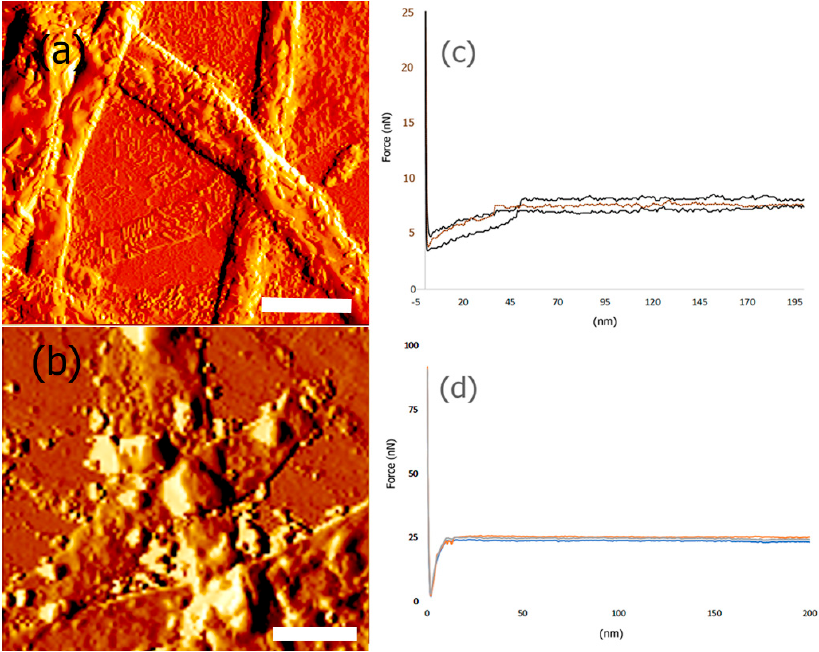
Figure 8. AFM amplitude image of ( a ) biocomposite nanoribbons bound to laminin, artemin and collagen. Scale Bar = 10 μ m; ( b ) nanoribbons bound to laminin, artemin and collagen and PANI. Scale Bar = 5 μ m. ( c ) Force curves obtained for biocomposite nanoribbons bound to laminin, artemin and collagen; ( d ) Force curves obtained for nanoribbons bound to laminin, artemin and collagen and PANI.